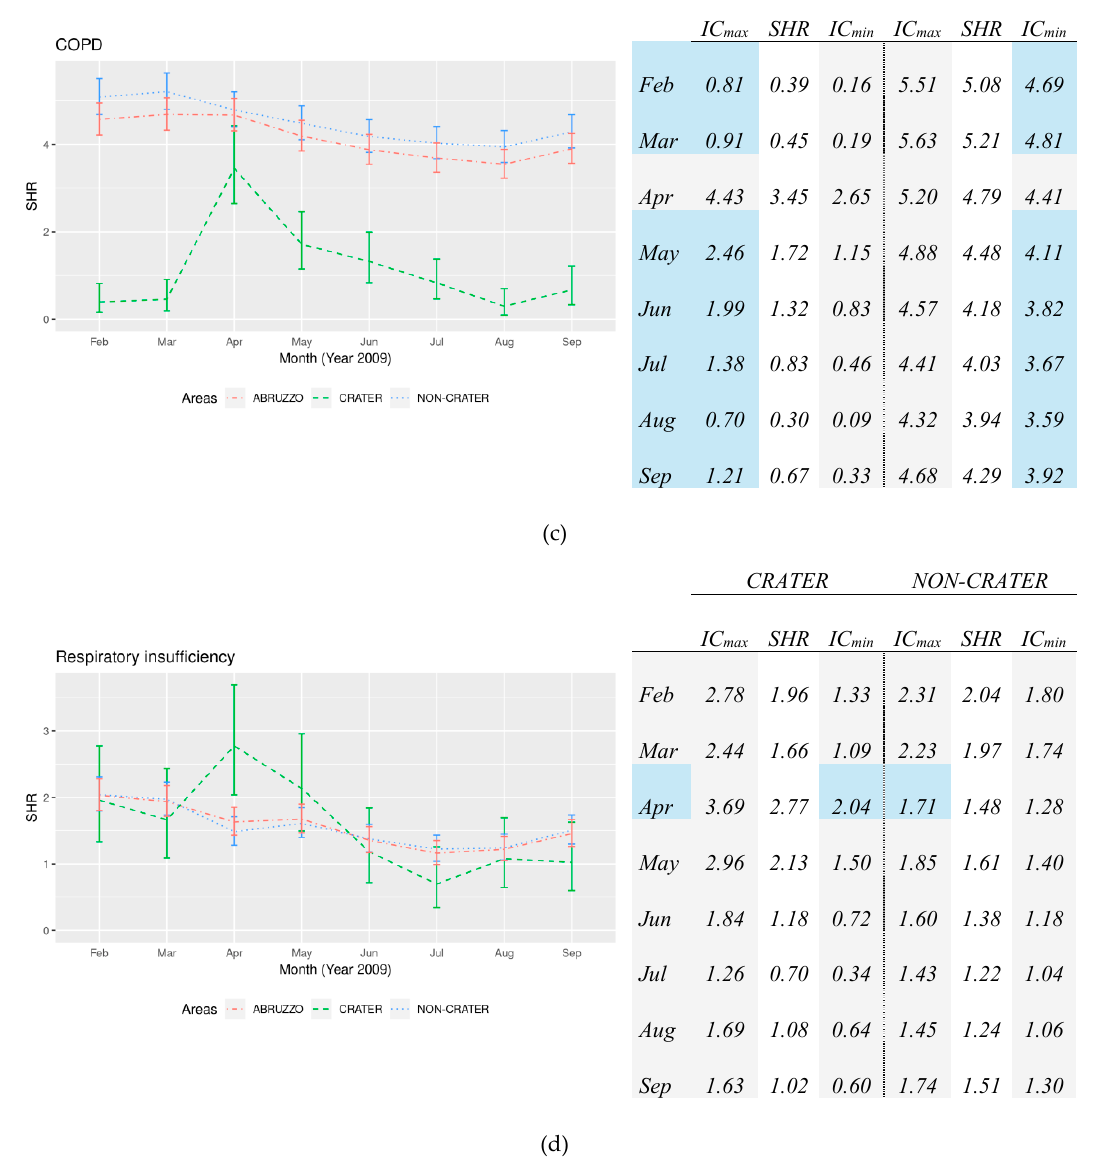
Figure 1. Standardized hospitalization rates (SHRs) for ( a ) respiratory disease, ( b ) pneumonia, ( c ) COPD and ( d ) respiratory insufficiency between February and September 2009 with Confidence Intervals 95%—data in the table below.